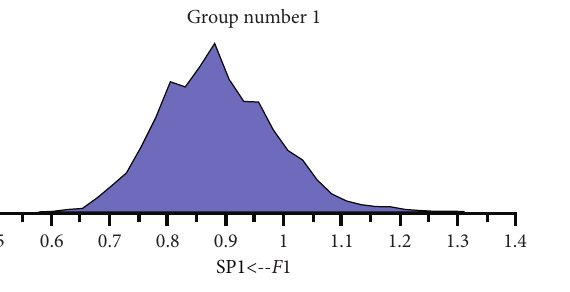
Figure 7: Bayesian diagnostic SP1.